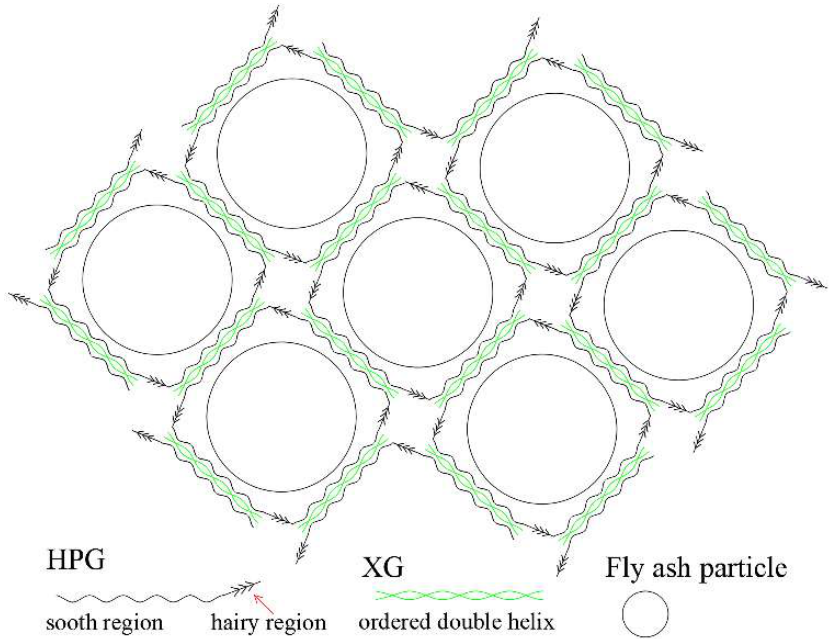
Figure 11. Schematic diagram of network structures between hydroxypropyl guar gum (HPG) and XG [51].